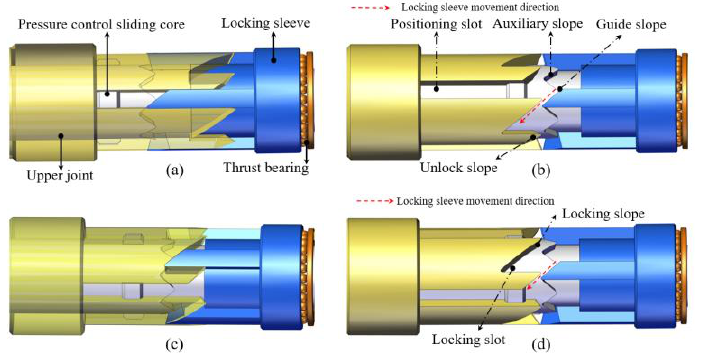
Figure 3. Working process of the self-locking mechanism: ( a ) the initial state of self-locking mechanism; ( b ) Self-locking process of self-locking mechanism; ( c ) the locked state of self-locking mechanism; ( d ) Unlocking process of the self-locking mechanism.